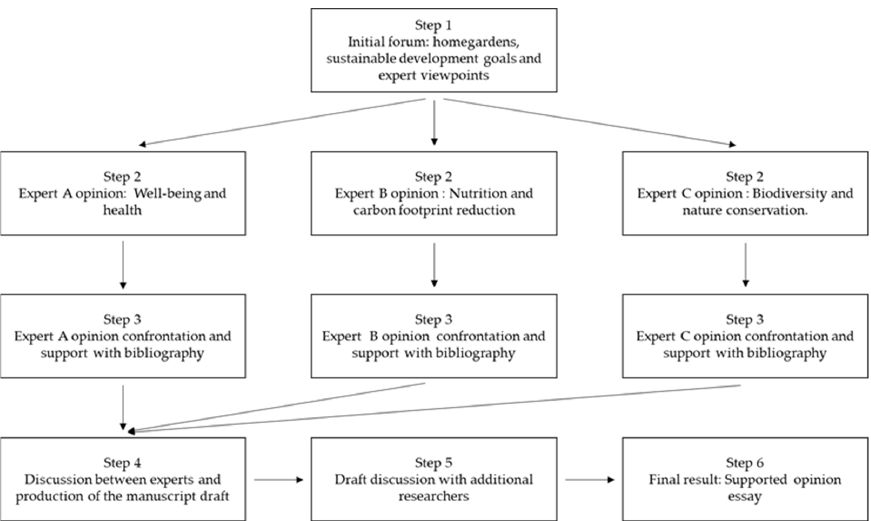
Figure 1. The stepwise framework used to structure our supported opinion essay: step 1, forum